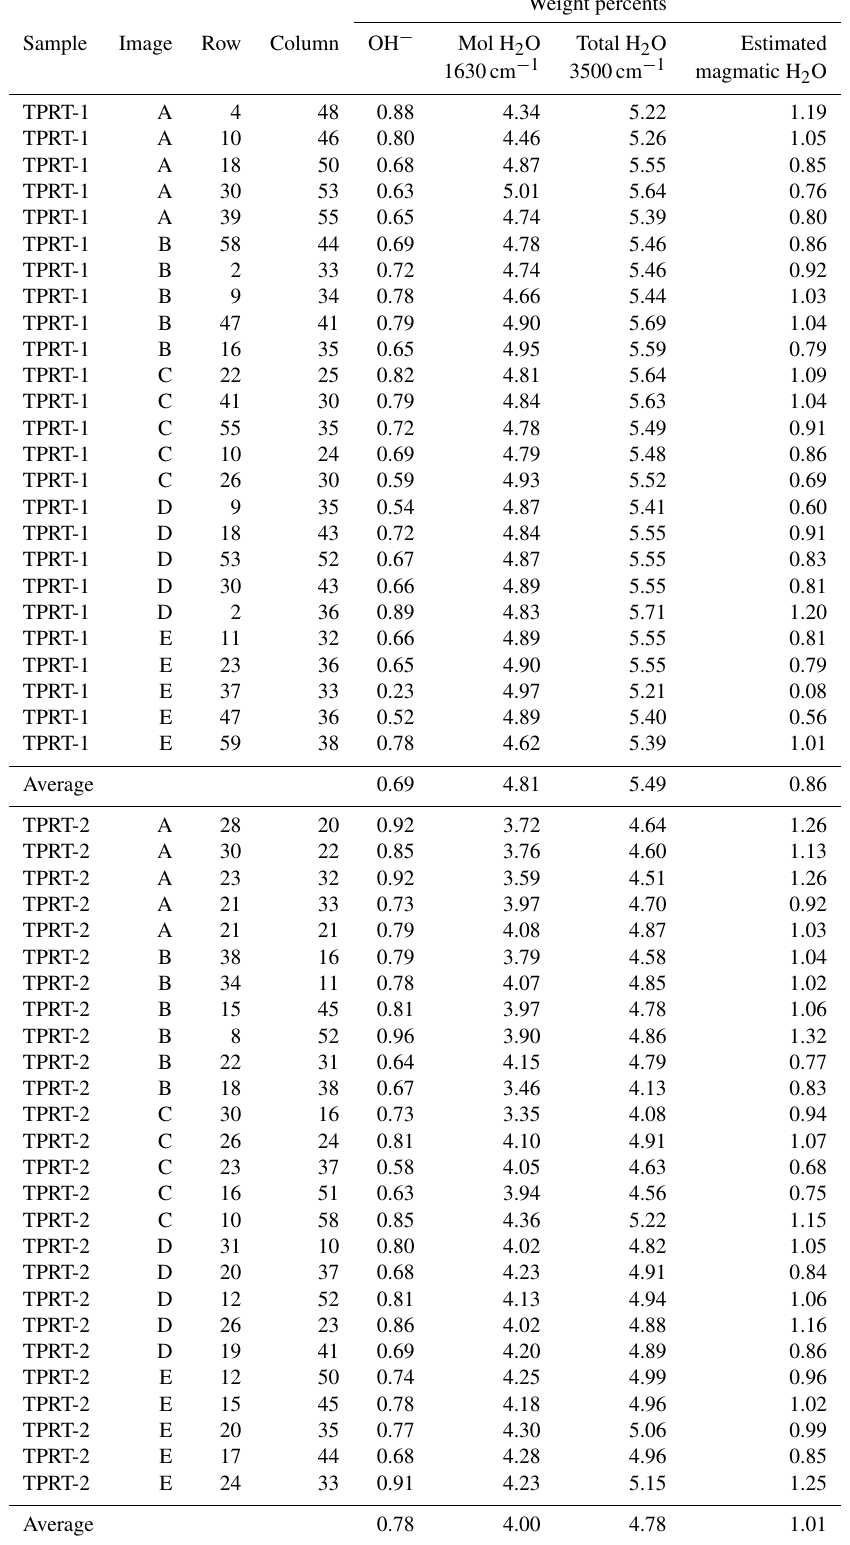
Table 2. Water content estimated by FTIR using a glass density of 2350gL − 1 , absorption coefficients of 55 (at 1630cm − 1 ) and 90